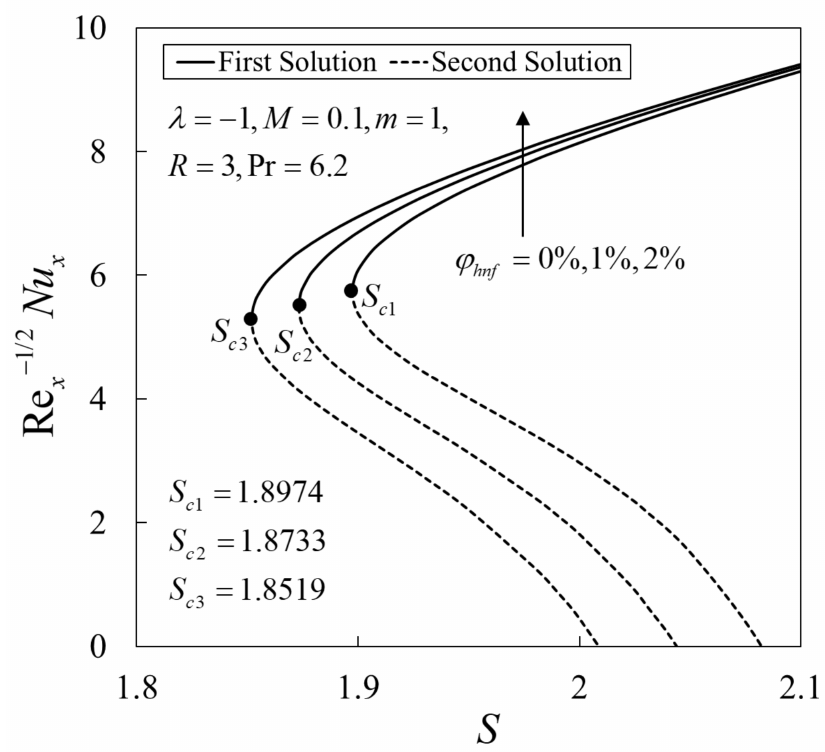
Figure 5. Variations of the local Nusselt number Re − 1/2 x Nu x against suction parameter S for different values of ϕ hnf